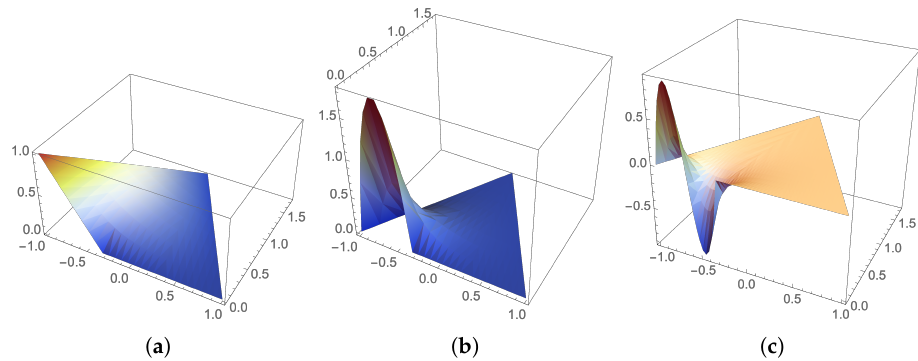
Figure 4. Triangle. ( a ) Nodal mode. ( b ) Edge mode with p = 2. ( c ) Edge mode with p =